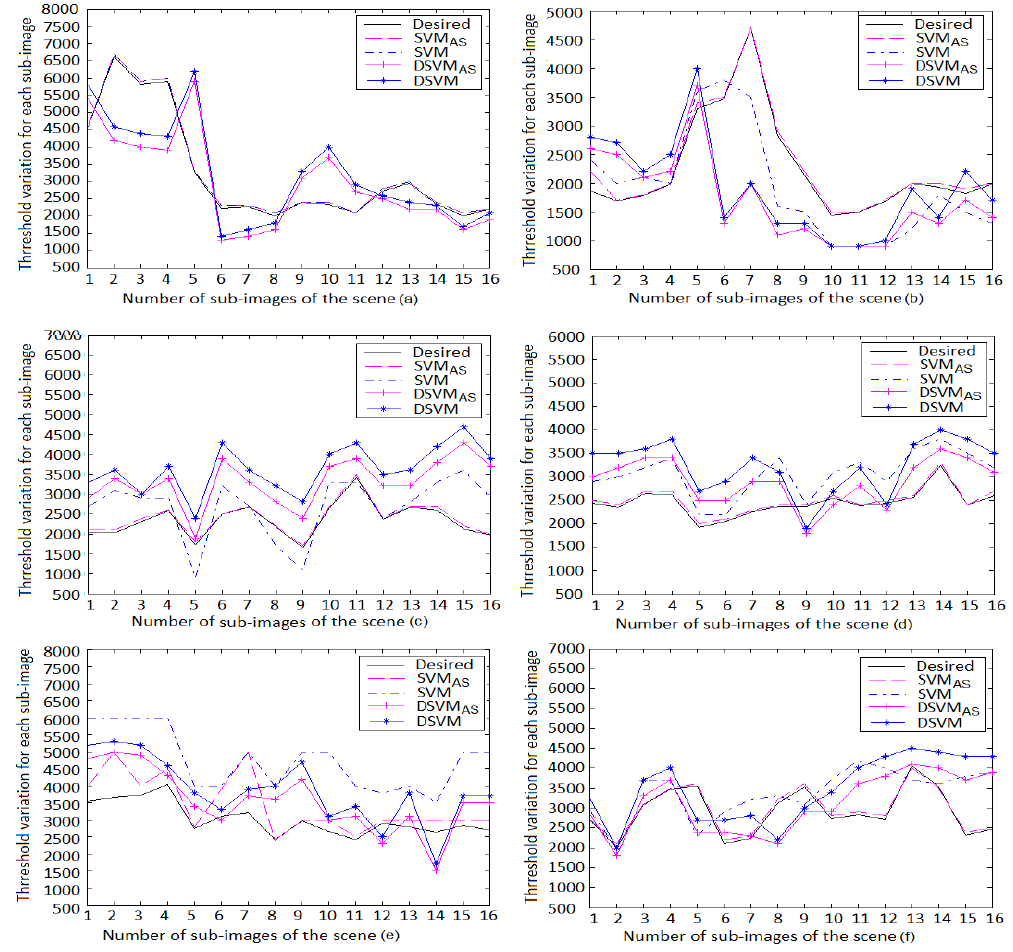
Figure 10. Variation of the thresholds for the 512 × 512 resolution scenes. It is shown that the SVM AS gives similar results to those of the human visual system (HVS) on the scenes ( a – f ). We also found that the DSVM AS model gives more coherent results to those of the human visual system (HVS) than DSVM does on the scenes ( a – f ) and achieves a better precision than SVM on the scenes ( d – f ). Table 5. Mean square error range for the 512 × 512 resolution scenes. The bold values simply indicate the minimum Mean square error range.